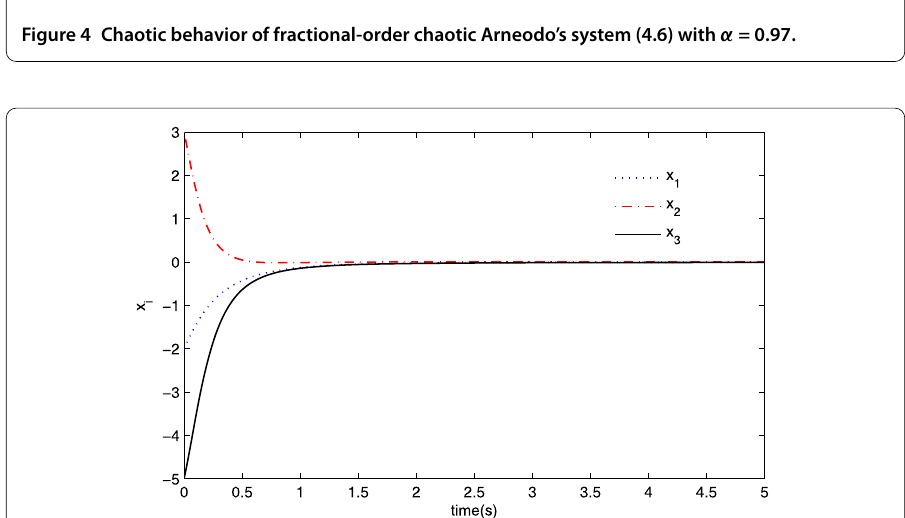
Figure 5 Asymptotic stabilization of system (4.6) with adaptive feedback